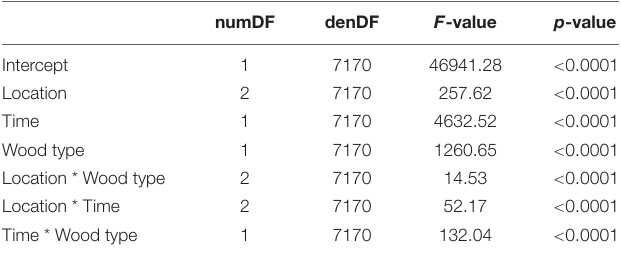
their interactions as fixed effects ( R 2 = 0.44, p <